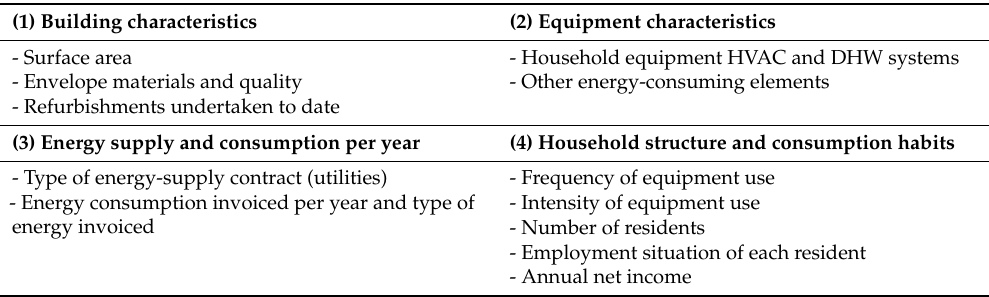
Table 1. Household information